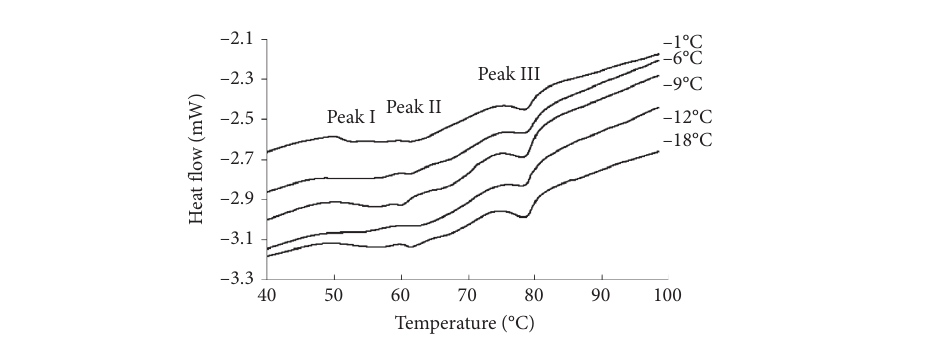
Figure 6: DSC thermograms of beef after frozen at − 1 ° C (for 28 days), − 6 ° C (for 84 days), − 9 ° C (for 126 days), − 12 ° C (for 168 days), and − 18 ° C (for 168 days).